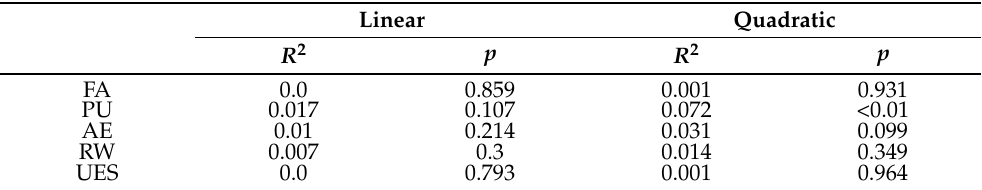
Table 8. Mean motion in relation to user engagement scale (short form) for a linear and quadratic regression model. Linear Quadratic R 2 p R 2 p FA 0.001 0.749 0.01 0.476 PU 0.004 0.452 0.062